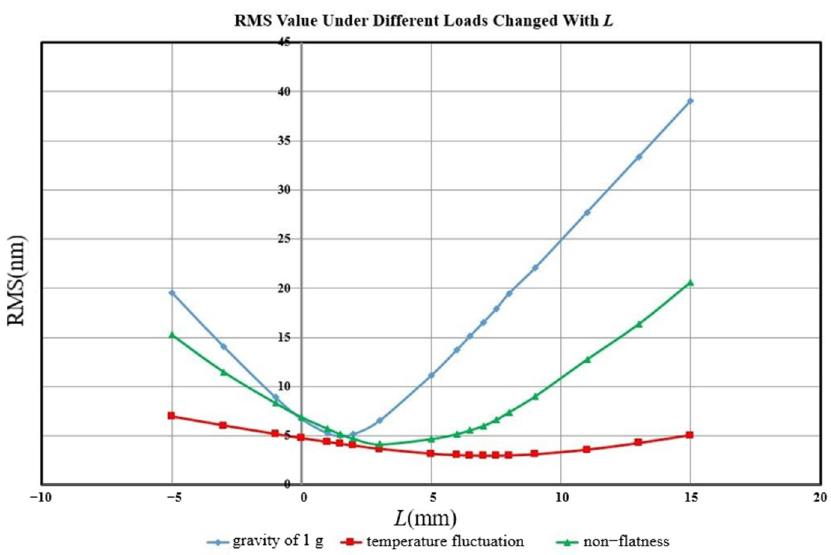
Figure 9. RMS value changed with distance L